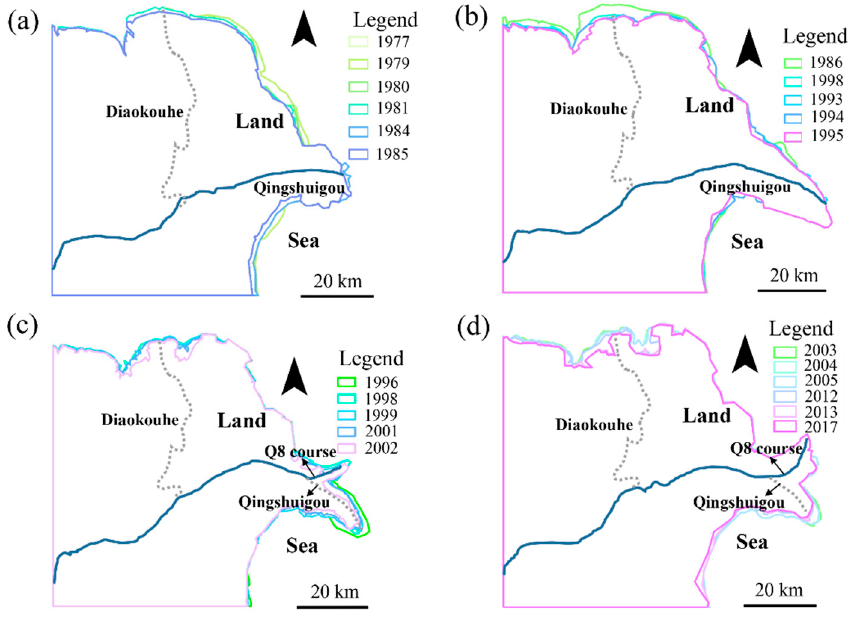
Figure 6. The shoreline changes ( a ) from 1977 to 1985, ( b ) from 1986 to 1995, ( c ) from 1996 to 2002 and ( d ) from 2003–2017 of the Yellow River Delta.